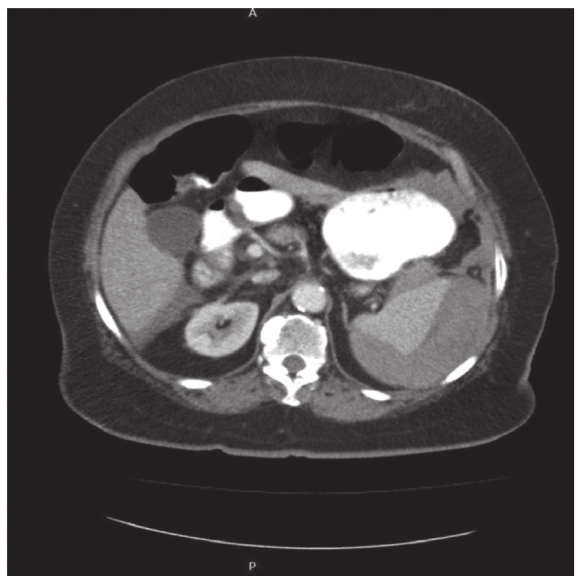
Figure 2: Axial CT scan section showing large subcapsular he- matoma of the spleen with